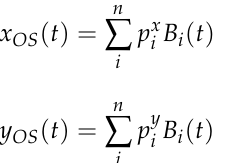
removing the initial knot vector { 0, 0, 1, 1 } , the maximum degree of B-spline basis function is 0.75. Therefore, the position information of collision avoidance trajectory can be illustrated with Figure 5.